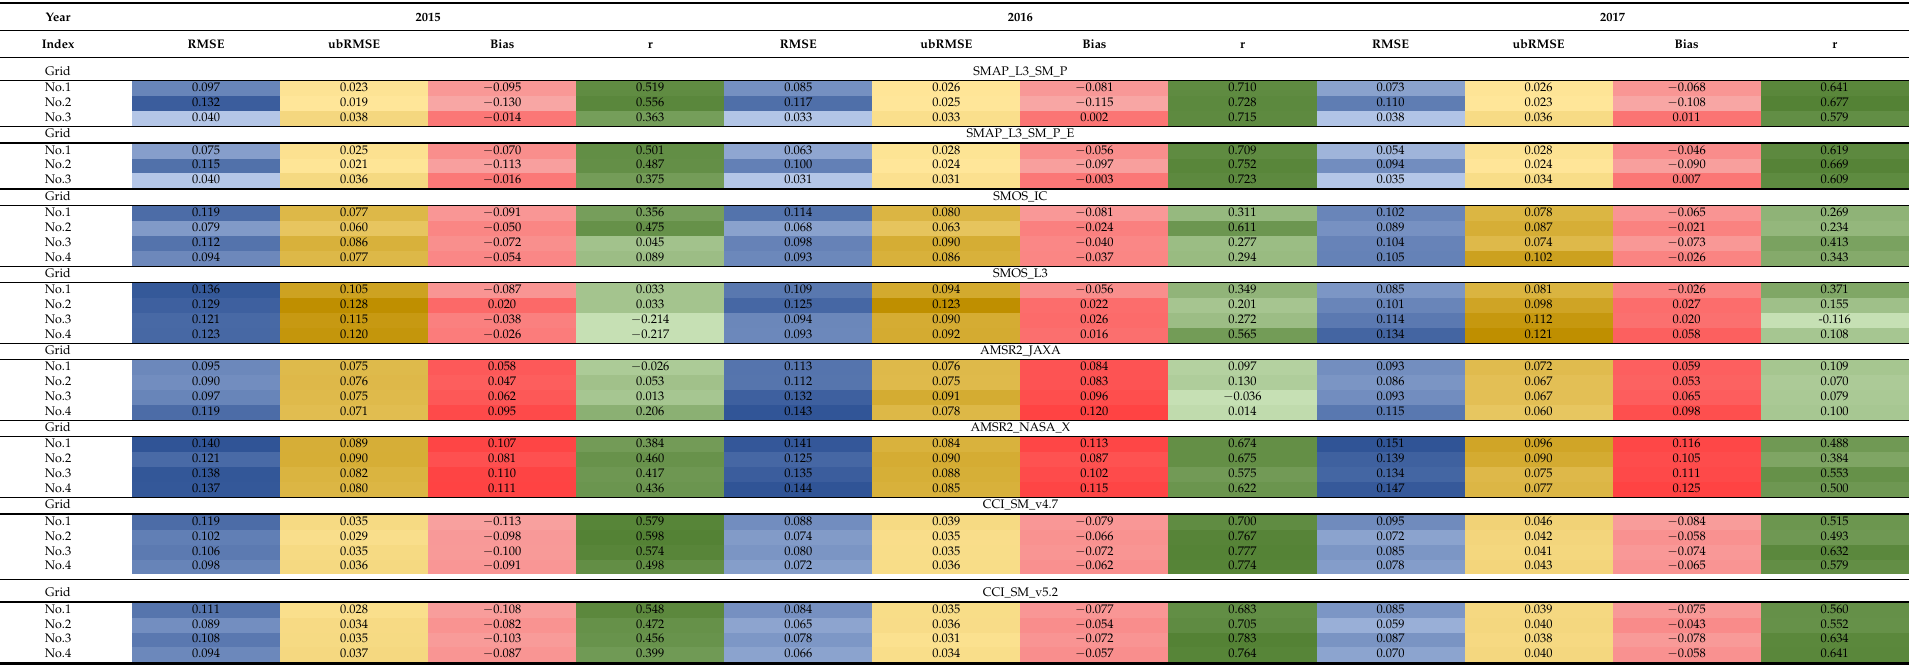
Table 3. Performance metrics of RS SM